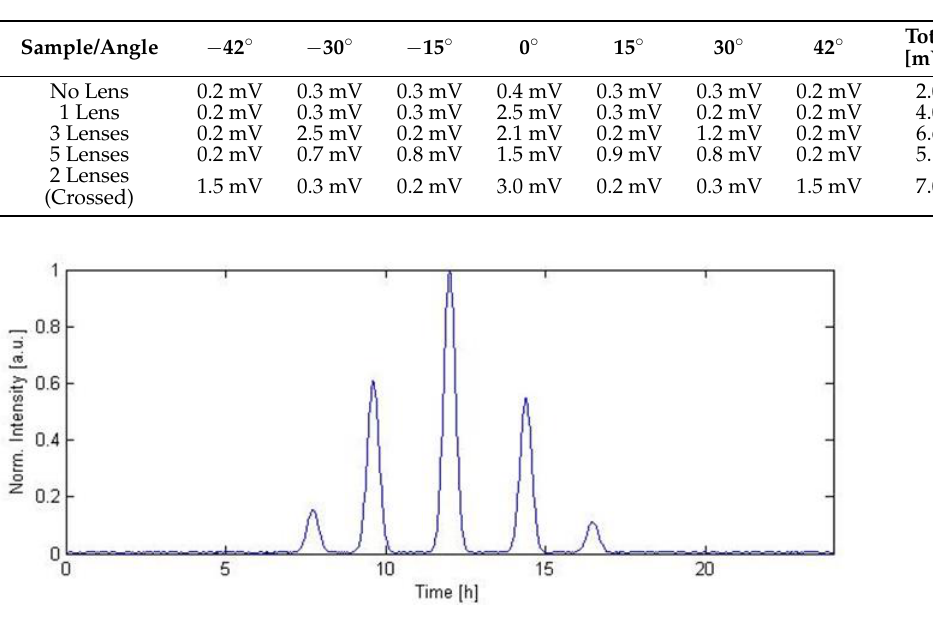
Figure 18. 24 h – Measurement of the concentrated solar intensity in real operative